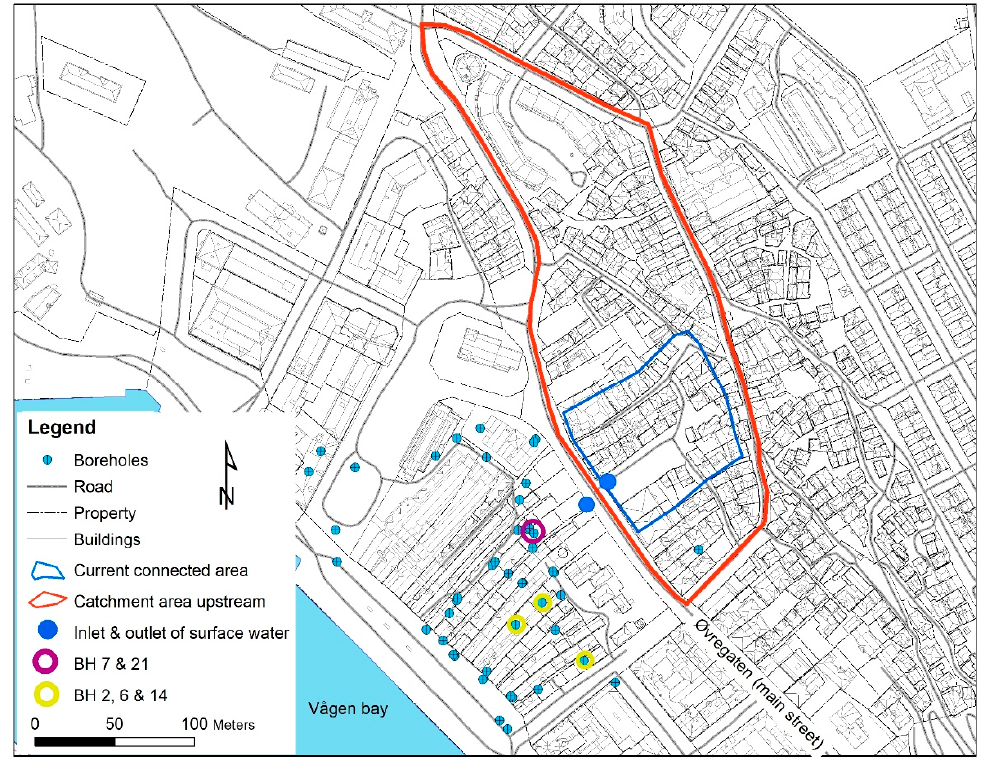
Figure 3. The catchment area and locations of boreholes. Figure 2. The catchment area and locations of